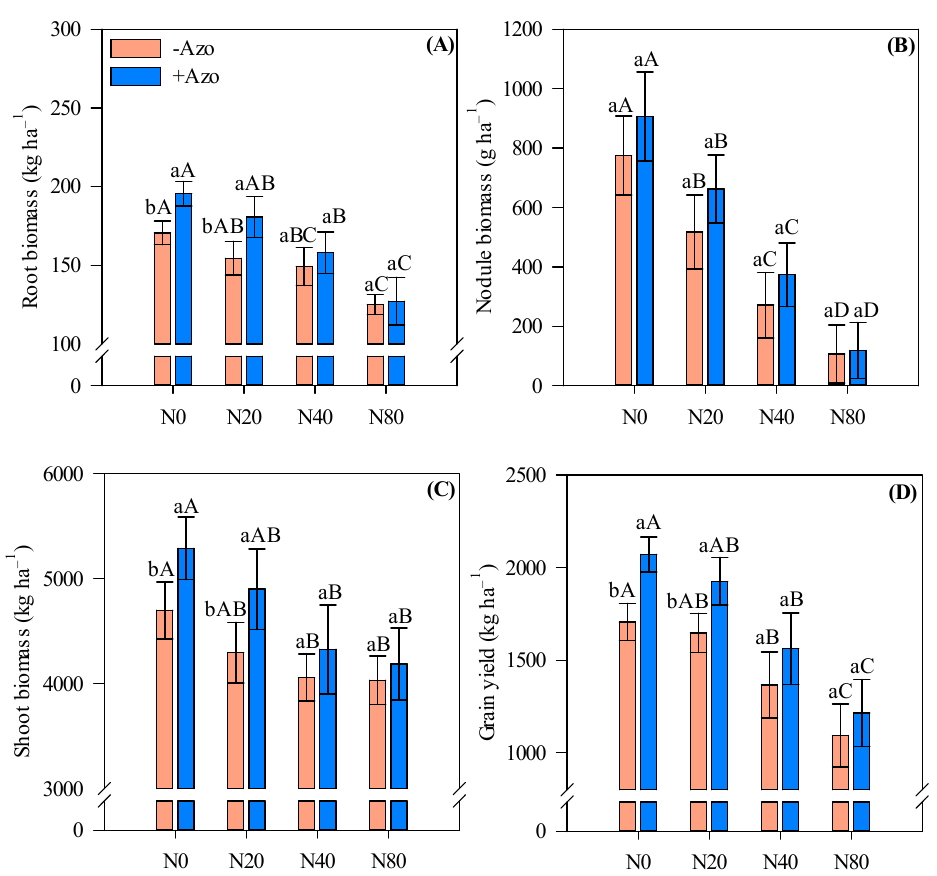
Figure 3. Root ( A ), nodule ( B ) and shoot ( C ) biomass and cowpea grain yield ( D ) affected by inoculations and N fertilizer rates. Different letters indicate significant differences between treatments according to Tukey’s test ( p ≤ 0.05). Interaction between inoculations and N levels: Lowercase letters indicate significant differences between inoculations, and uppercase letters indicate significant differences between N levels according to Tukey’s test ( p ≤ 0.05). Error bars indicate standard deviations ( n = 4). − Azo and +Azo refer to the single inoculation with Bradyrhizobium sp. and co-inoculation with Bradyrhizobium sp. + A. brasilense, respectively; N0, N20, N40 and N80 refer to absence, 20, 40 and 80 kg N ha −1 applied.